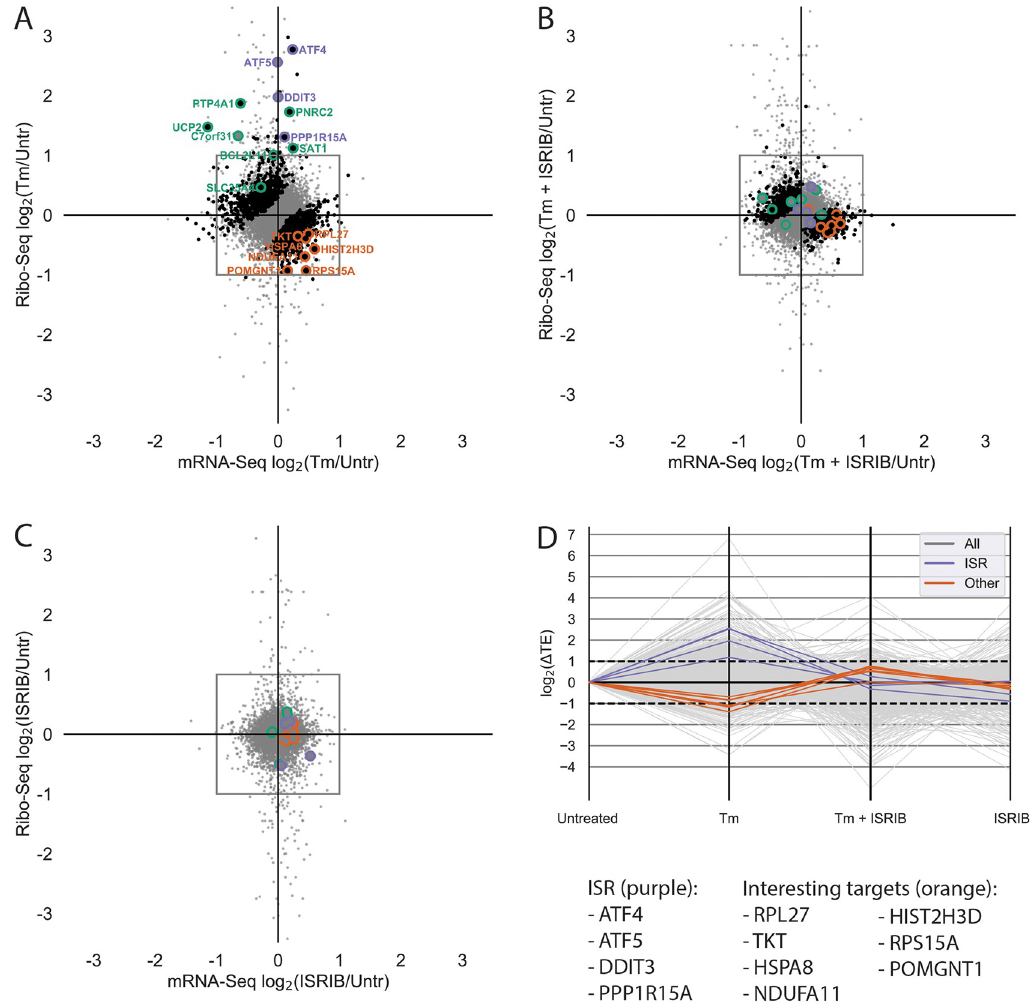
Fig 3. Analysis of previously published ISR TE data using XPRESSpipe. A-C) log 2 (Fold Change) for each drug condition compared to untreated for the Ribo-seq and RNA-Seq data. Purple, ISR canonical targets highlighted in the original study. Green, genes with uORFs affected by ISR as highlighted in the original study. Orange, genes fitting a strict TE thresholding paradigm to identify genes that display a 2-fold or greater increase in TE in Tm + ISRIB treatment compared to Tm treatment. Black, genes with statistically significant changes in TE. Grey, all genes. Changes in Ribo-seq and mRNA-Seq were calculated using DESeq2. TE was calculated using DESeq2. Points falling outside of the plotted range are not included. D) Changes in log 2 (TE) for each drug condition compared to untreated control. Grey, all genes. Purple, ISR targets identified in the original study. Orange, genes fitting a strict TE thresholding paradigm to identify genes that display a 2-fold or greater increase in TE in Tm + ISRIB treatment compared to Tm treatment. XPRESSpipe-processed read alignments were quantified to Homo sapiens build CRCh38v98 using a protein-coding-only, truncated